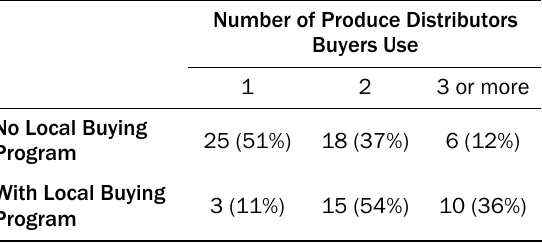
Table 1. Number of Produce Distributors by Local Buying Program Status